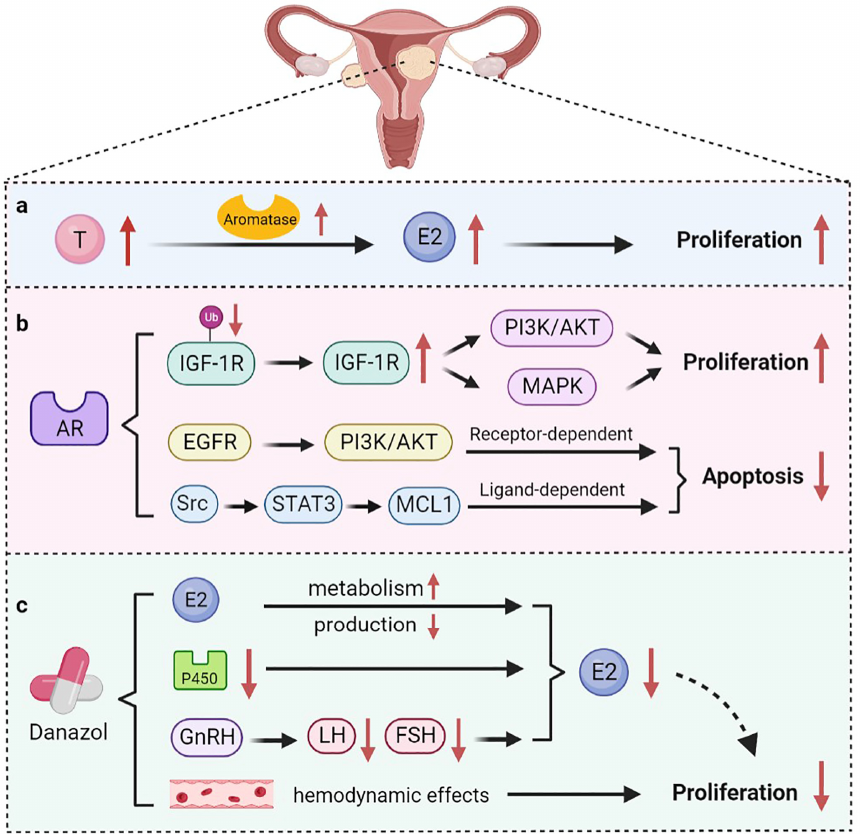
Figure 2. The role of androgen in uterine fibroids. ( a ) Testosterone is converted into E2 under the action of aromatase, thereby promoting the growth of uterine fibroids; ( b ) AR maintains the stability of IGF-1R protein and triggers the PI3K/AKT and MAPK pathways to promote cell proliferation. AR also mediates anti-apoptotic functions through receptor-dependent and ligand-dependent path- ways; ( c ) Danazol normalizes estrogen metabolism and affects the production of FSH and LH, ulti- mately inhibiting estrogen production. Danazol can also affect the hemodynamic effects of uterine